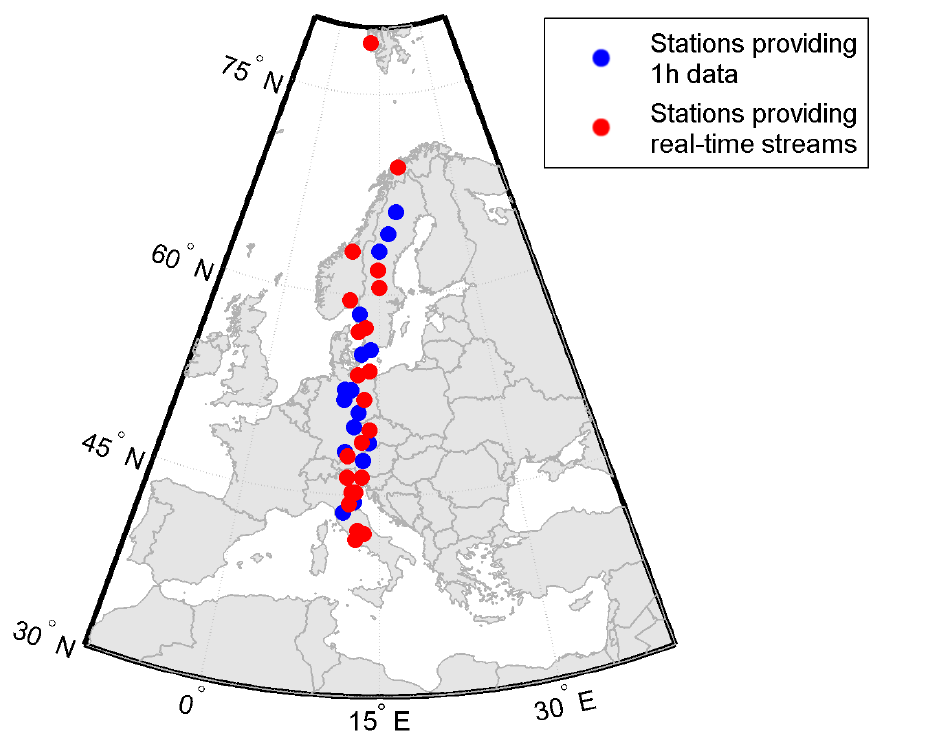
Figure 1. Map of the EPN stations located between 10 and 20 ◦ E selected for meridional ROTI time series. Blue dots mark stations providing 1 h data; red ones—stations with real-time data stream